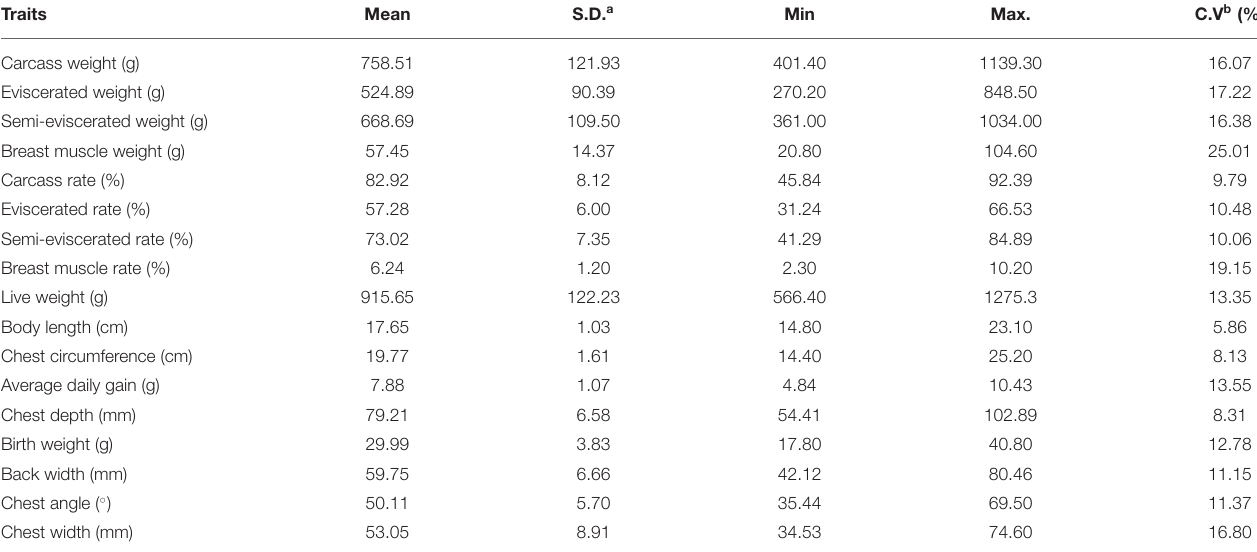
TABLE 1 | Summary statistics of growth and carcass traits from Chinese Ningdu yellow chicken population.